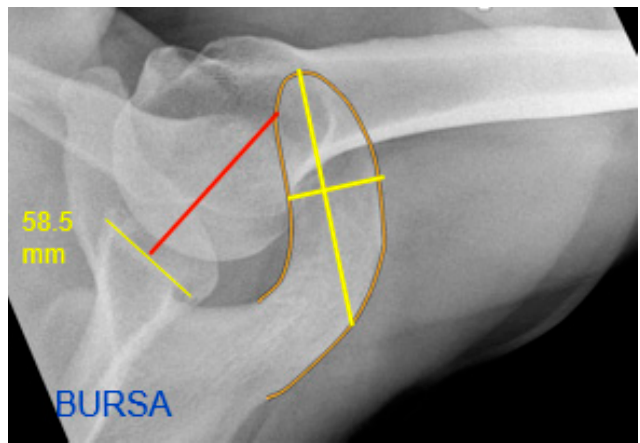
Figure 4. Left axillary shoulder radiograph: medial border offset (red), length/width of the acromion (bright yellow).